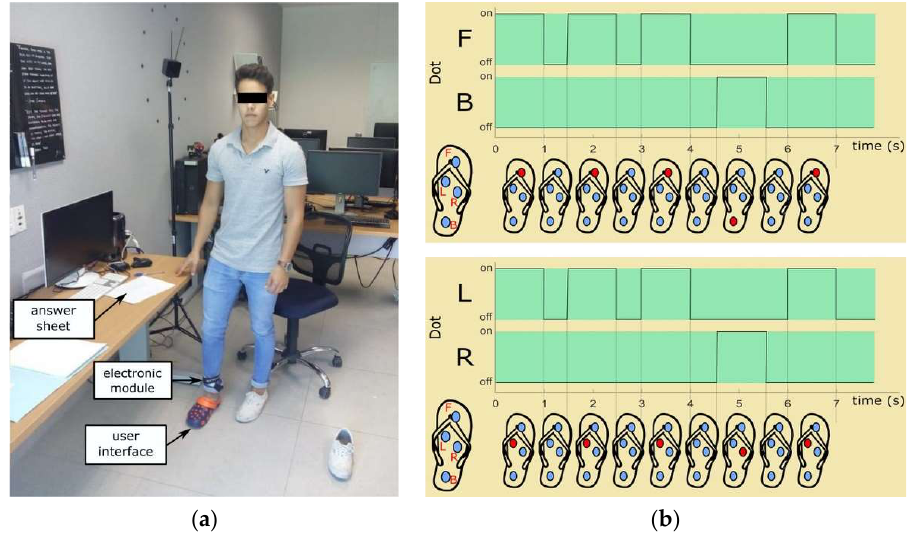
Figure 5. Navigational instruction recognition experiment: ( a ) setup and ( b ) vibrating patterns for (top) going forward and (down) turning left. The dot being actuated is represented in red. The whole pattern lasts 7 s. Table 2. Navigational instruction recognition rates with the user interface and the proposed tactile rendering approach.